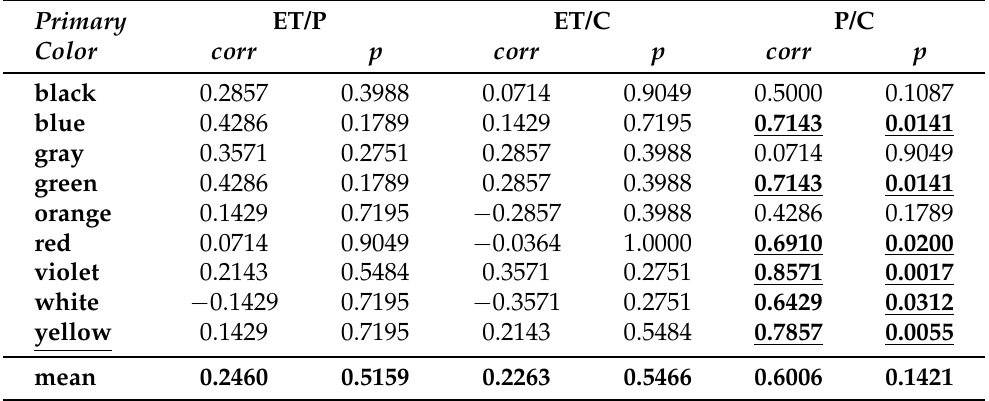
Table 1. Kendall correlations and significance level results for objective data (ET), subjective data (P), and contrast (C). Values with p < 0.5 are marked in bold and